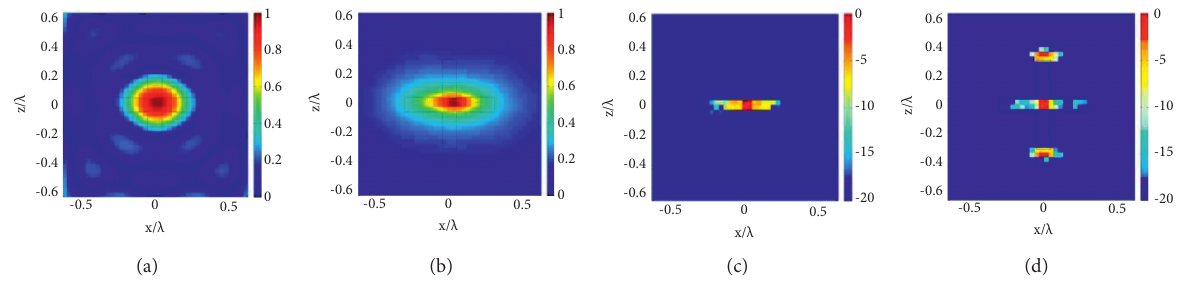
Figure 9: Reconstruction of the cross-shaped object a � 0.3 λ in xOz plane and φ -oriented dipoles. (a) TSVD, (b) LSM, (c) SSP, and (d) SHSP. SNR �